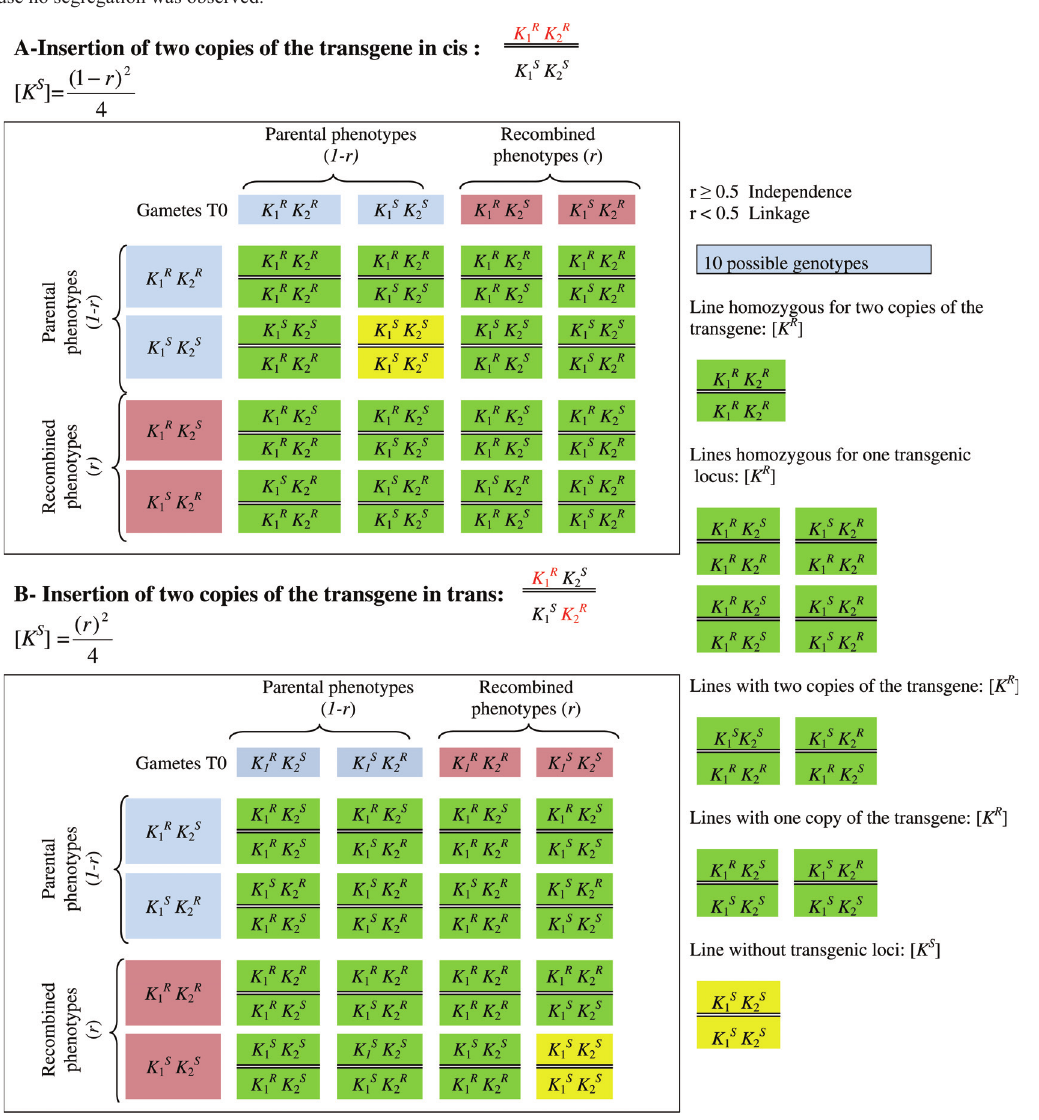
Figure 1 - Segregation of two copies of the transgene linked in cis (A) or trans (B). K 1 R and K 2 R indicate transgenic loci whereas K 1 S and K 2 S indicate ab- sence of the transgene on the chromosome. [ K R ] and [ K S ] are the kanamycin-resistant and kanamycin-sensitive phenotypes, respectively. r - recombina- tion frequency between the linked inserts. Gametes T0 are gametes produced by T0 transformed plants. When r (cid:4) 0.5, the two transgenes segregate inde- pendently while for r < 0.5 the two transgenes recombined with a frequency ( r ) equal to the distance separating the physically linked